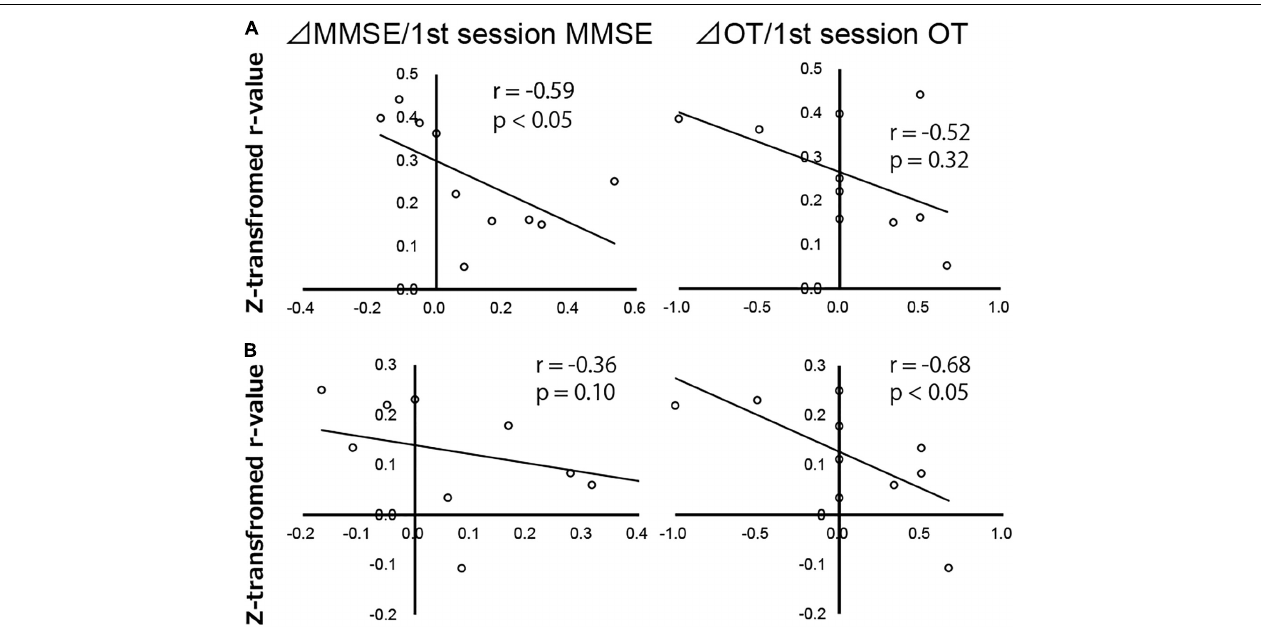
FIGURE 5 | Correlation map of Alzheimer’s disease patients between change in Mini-Mental State Examination score ( (cid:49) MMSE)/first session MMSE score, change in orientation for time score ( (cid:49) OT)/first session OT score, and z-transformed r -values of the dorsal attention network to the (A) right planum temporale and (B) anterior cingulate gyrus, analyzed using Spearman’s rank correlation test. Each circle represents data from one